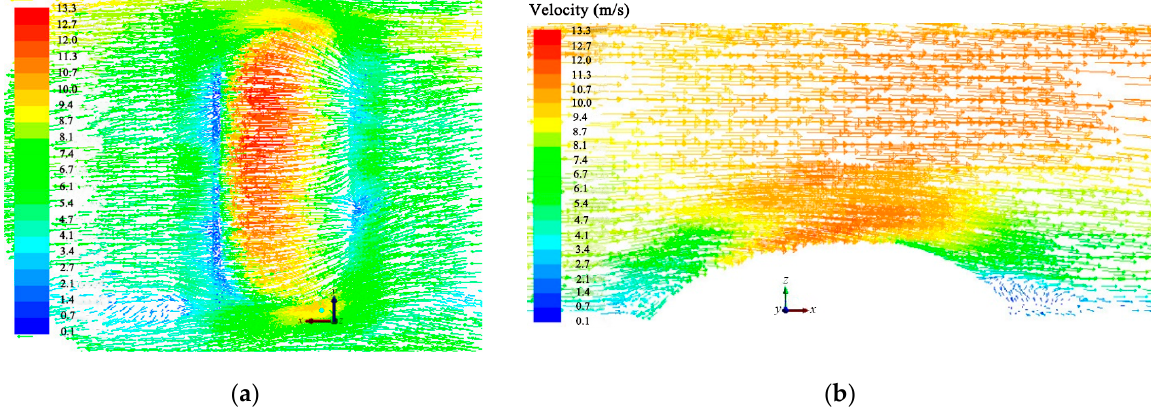
Figure 15. Instantaneous velocity contours with streamlines: ( a ) The xy -plane; ( b ) The xz